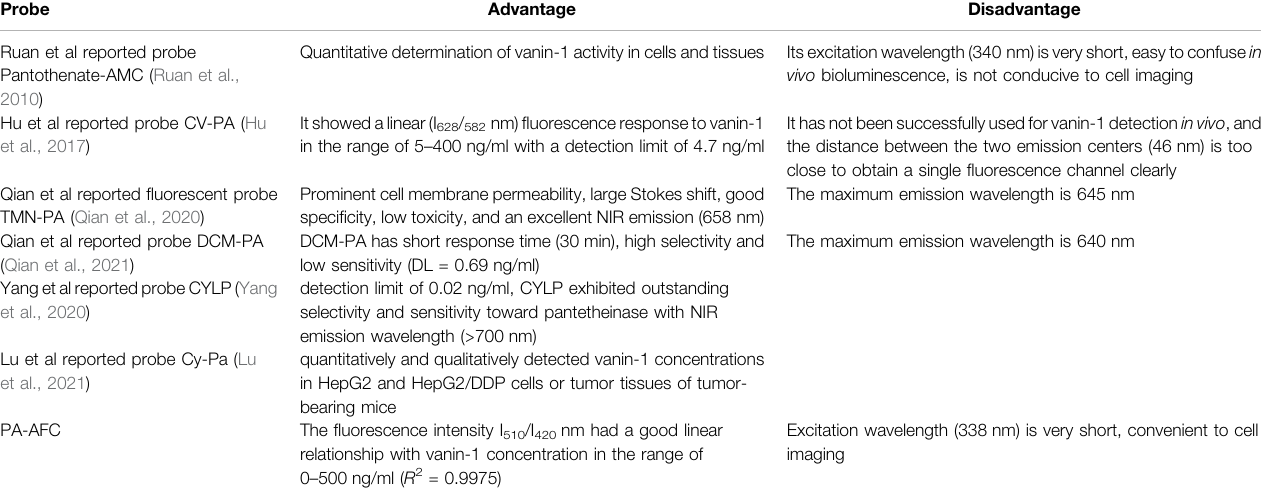
TABLE 1 | The summary of fl uorescent probes for VNN1.